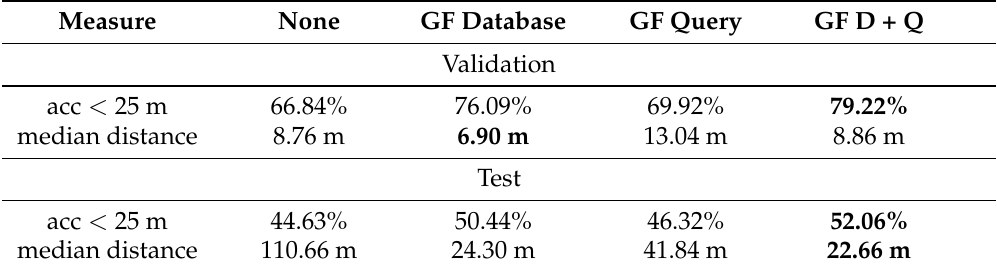
Table 2. Results under different graph filter conditions for the Mapiliary Adelaide dataset. GF means Graph Filtering. The best performance for each row is bolded.